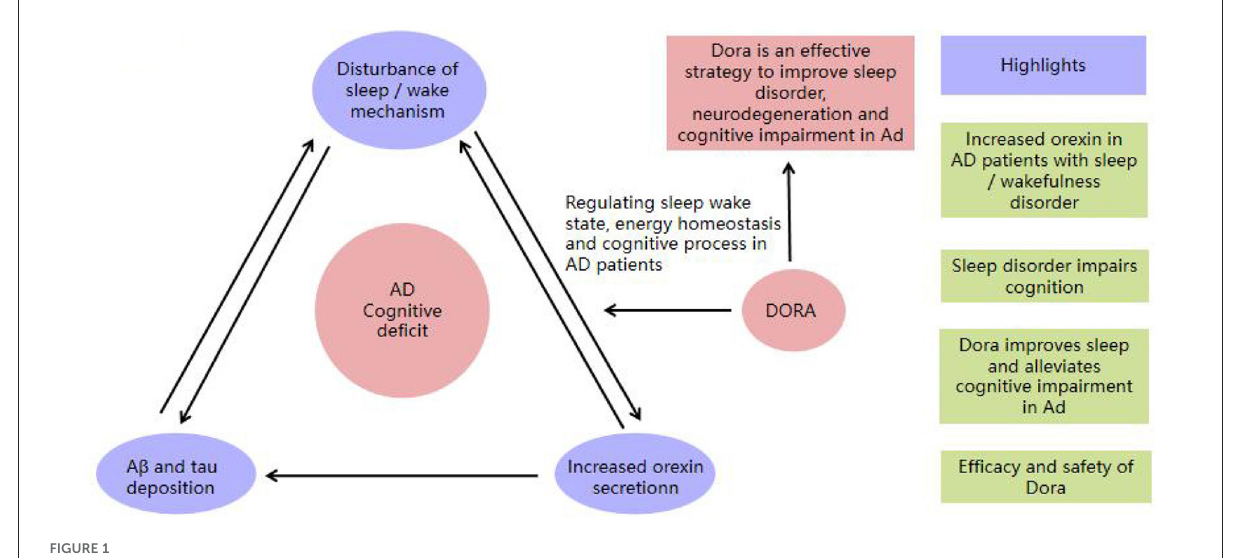
FIGURE1 The schematic diagram of DORA intervention in